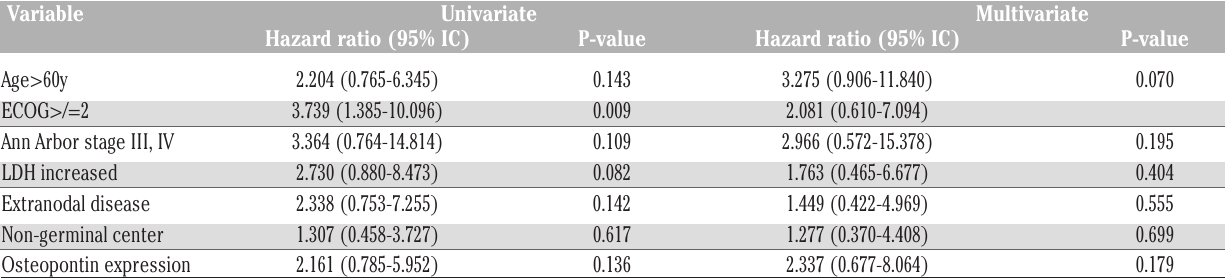
Table 3. Univariate and multivariate Cox regression analysis prognostic factors for OS.